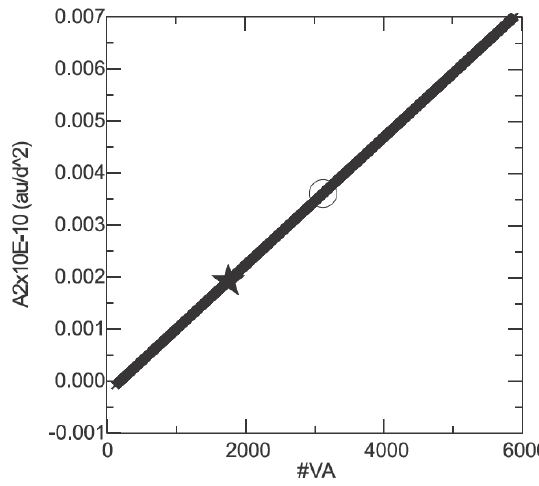
Figure 4. The LOV 1 method. 6001 VAs of the asteroid 2001 BB16 with different non-gravitational parameter A 2. Circle denotes the position of nominal orbit and star - position of VA#1632 for orbit close to impact in